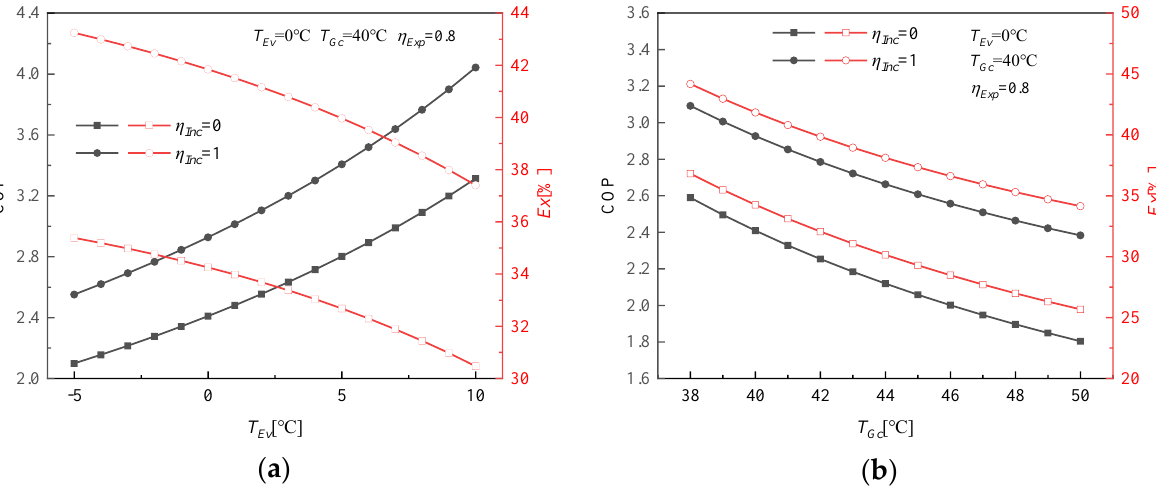
Figure 11. Effect of η Inc on system performance. ( a ) System performance variation with T Ev ; ( b ) System performance variation with T Gc